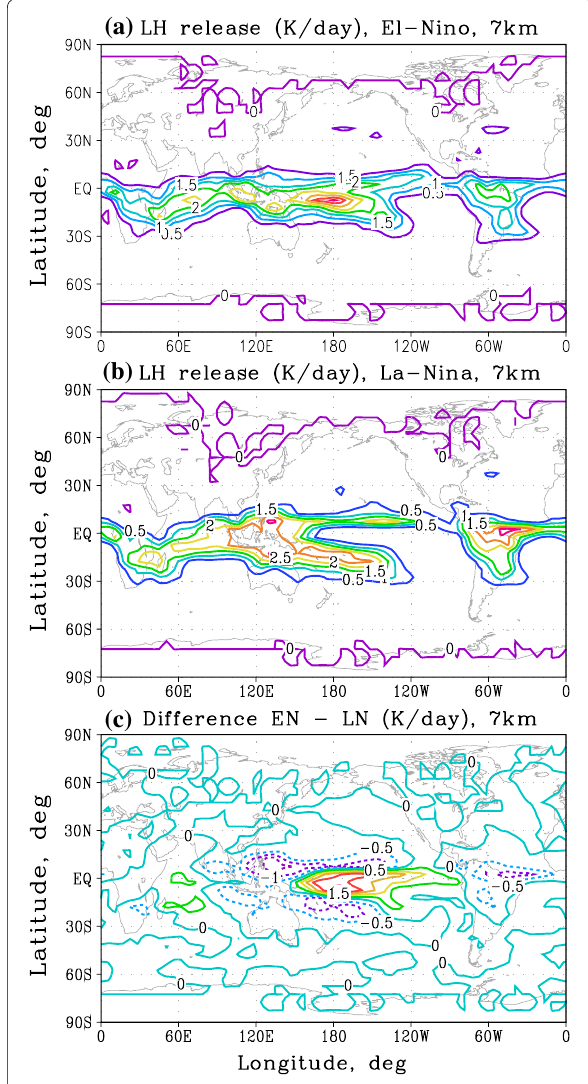
Fig. 1 Monthly mean (January) latent heat distribution at 7 km altitude during El Niño ( a ) and La Niña ( b ) conditions; heating difference of El Niño and La Niña ( c